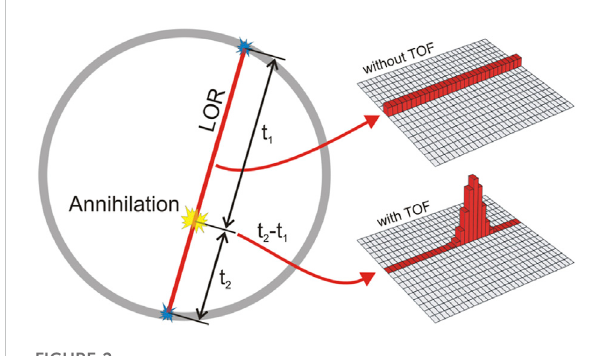
FIGURE 2 LOR for traditional (non-TOF) PET and TOF-PET. The probability of the annihilation location without TOF is uniform across the LOR. Using TOF, the probability can now be adjusted to fi nd the most likely location of the annihilation. Reproduced under CC-BY 4.0 license from